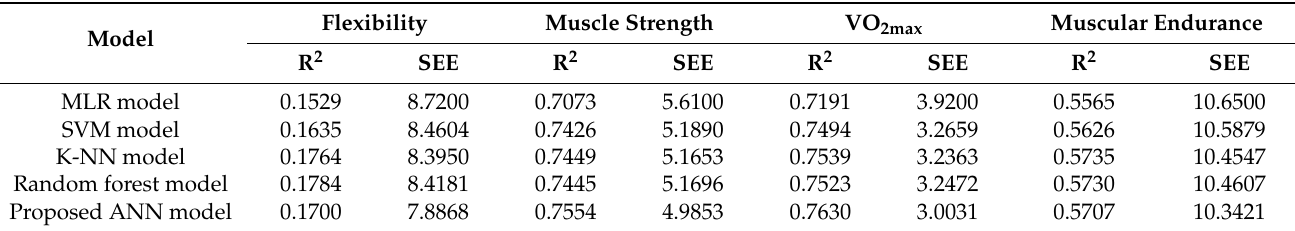
Table 5. Comparison of estimation accuracy between the four machine learning models and the MLR model.